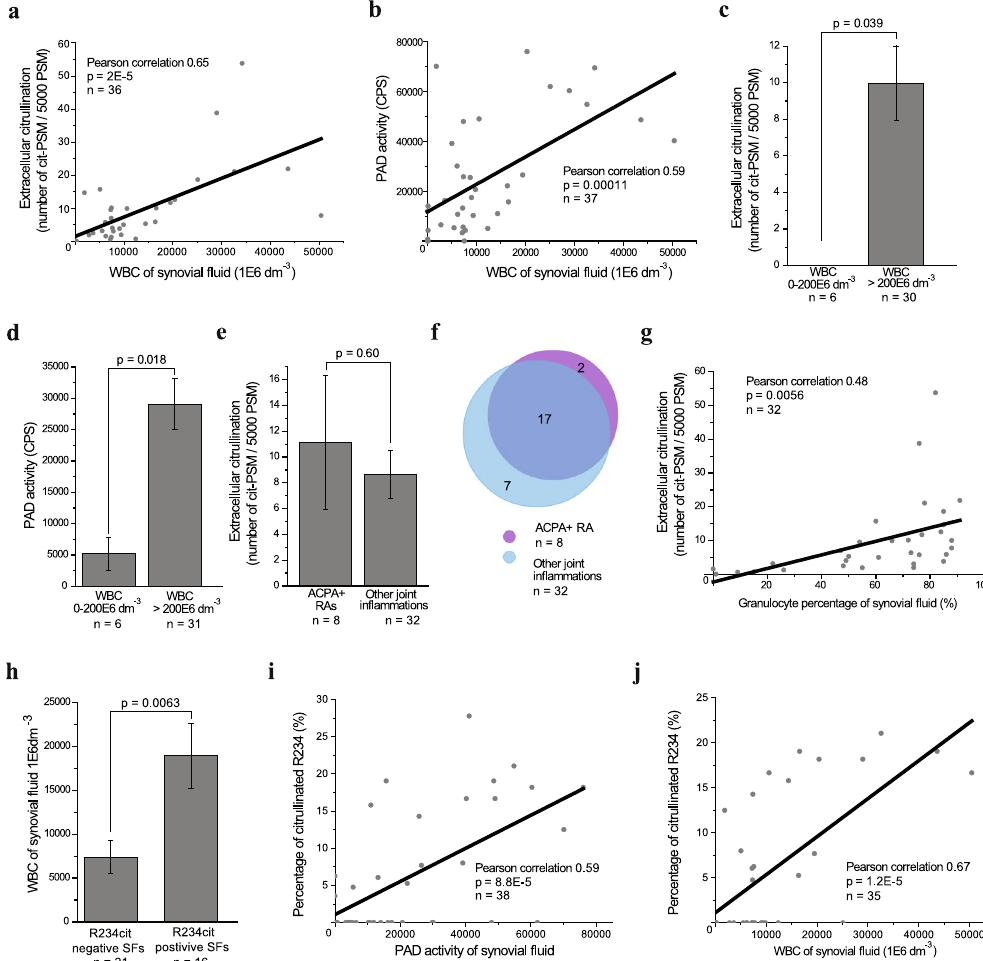
Figure 3. Extracellular citrullination associates with inflammation markers. ( a ) Correlation of extracellular citrullination (mass spectrometry, MS) and white blood count (WBC). ( b ) Correlation of PAD activity (enzyme assay) and WBC. ( c ) The level of extracellular citrullination (mass spectrometry) in inflammatory (WBC over 200 × 10 6 dm − 3 ) and non-inflammatory synovial fluids. ( d ) PAD activity (enzyme assay) in inflammatory (WBC over 200 × 10 6 dm − 3 ) and non-inflammatory synovial fluids. ( e ) Level of extracellular citrullination (mass spectrometry) in anti-citrulline antibody positive and negative RAs. ( f ) Number of identified citrullinated extracellular proteins in anti-citrulline antibody positive and negative RAs. ( g ) Correlation between extracellular citrullination and the relative amount of granulocytes among white blood cells. The number of samples varies because in some cases the university hospital did not routinely perform standard assays. ( h ) The WBC in the synovial fluid samples in which the citrullination of R234 in fibronectin, the known integrin binding site, can be detected. ( i ) The correlation between the citrullination level of R234 in fibronectin and PAD activity. ( j ) The correlation between the citrullination level of R234 in fibronectin and WBC. P-values were calculated with two-tailed Student’s t-test. Error bars show